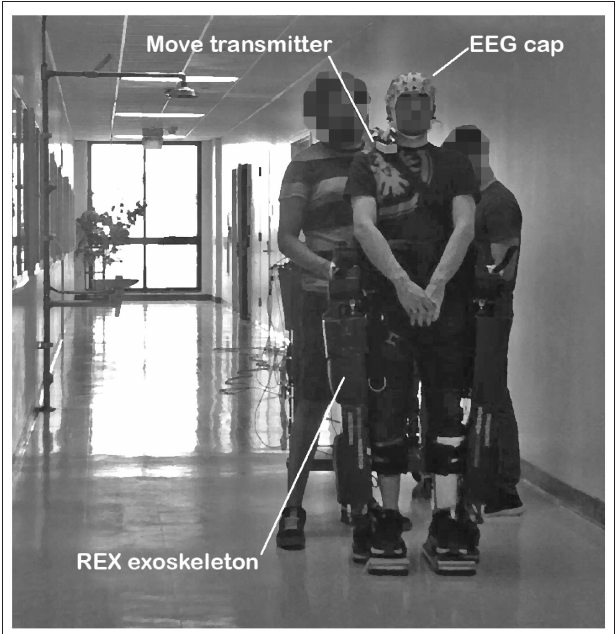
FIGURE 1 | Image of a subject executing one of the experimental